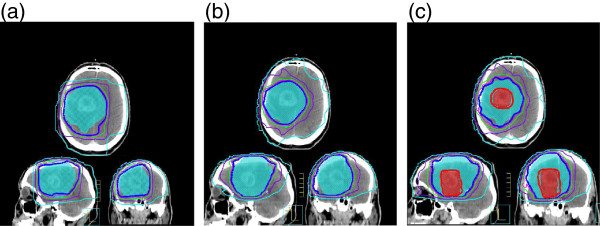
Comparison of dose plans between 60-Gy 3D-CRT, 60-Gy IMRT and 72-Gy SIB-IMRT. 60-Gy 3D-CRT and 60-Gy IMRT plans (respectively Figures3a and 3b) have one PTV1 color-washed in blue. The integration of Cho/NAA abnormal volumes defines new target relative to MRSI, i.e. PTV2 color-washed in red (Figure 3c), PTV1 is the same. The isodoses of 68.4 Gy (thick red isodose) and 57 Gy (thick dark blue isodose) represent 95% of the prescribed dose respectively 72 Gy and 60 Gy on the PVT2 and PTV1. The isodose volumes of 54 Gy (pink), 50 Gy (green), 36 Gy (purple) and 18 Gy (light blue) for organs at risk sparing are also plotted.